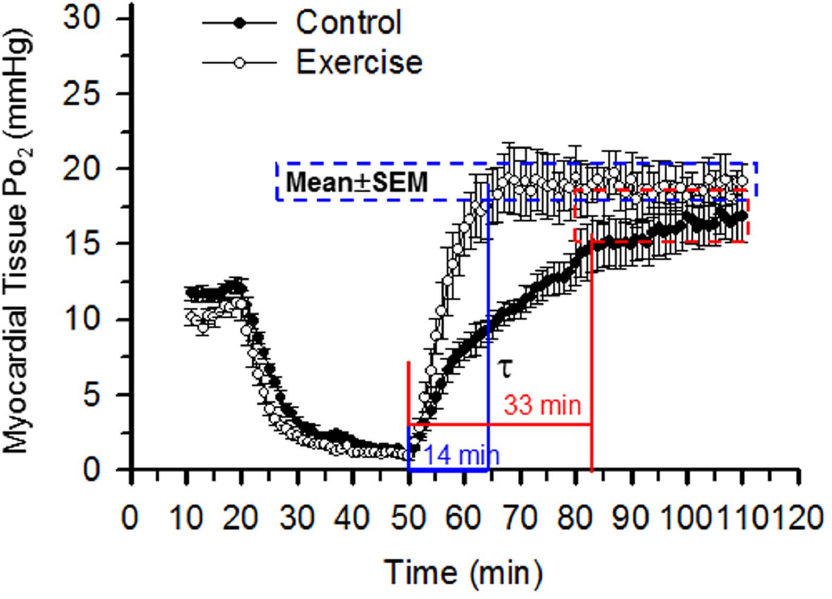
Figure 1. Myocardial tissue oxygenation during ischemia and reperfusion. In vivo EPR oximetry was performed to measure myocardial tissue oxygenation (Po 2 ) before (0–20 min), during (20–50 min), and after (50–110 min) ischemia and reperfusion (N 5 5/group). Myocardial tissue oxygenation recovery time t was measured from the start of reperfusion to plateau. As shown, endurance exercise dramatically shortened t from 33 (control) to 14 min without significant changes in oxygenation levels at baseline or after reperfusion